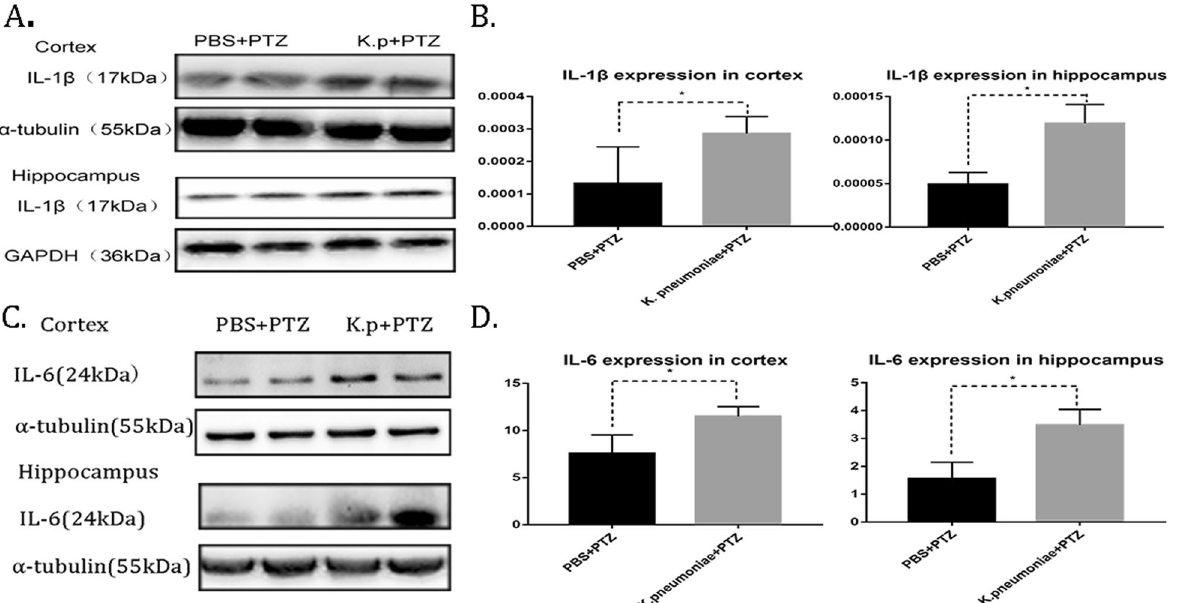
Fig. 4 K. pneumoniae activates microglia mediated in fl ammatory response in mice. A , B Representative images and the quanti fi cation of IL- 1 β expression in the cortex and hippocaumps after PTZ injection. Compared with that in the controls, IL-1 β expression was increased in the cortex and hippocampus in the K. pneumoniae group ( n = 3 in each group; * P < 0.05, Student ’ s t test). C , D Representative images and the quanti fi cation of IL-6 expression in the cortex and hippocaumps after PTZ injection. Compared with that in the controls, IL-6 expression was increased in the cortex and hippocampus in the K. pneumoniae group ( n = 3 in each group; * P < 0.05, Student ’ s t